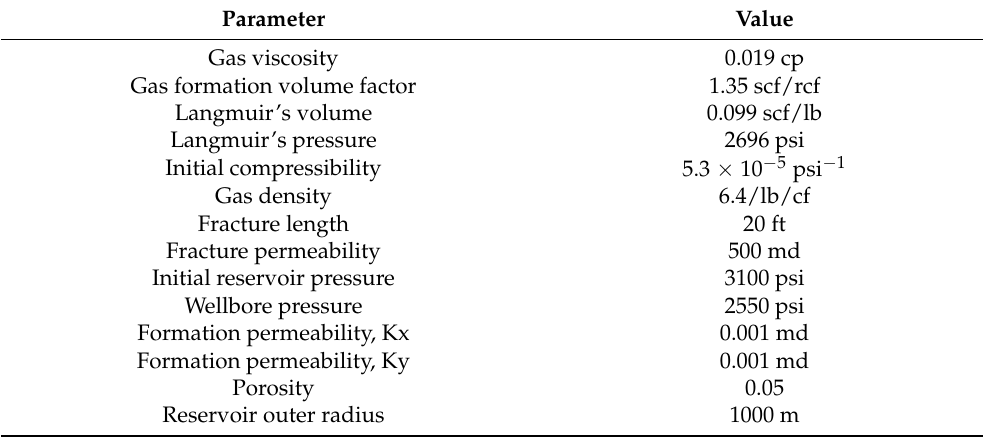
Table 2. Shale gas reservoir properties used in the verification of the developed numerical model.